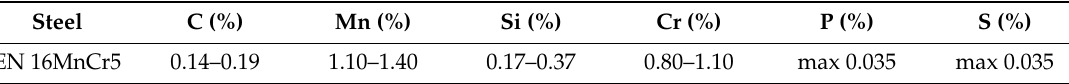
Table 3. Chemical composition of 1.7131 steel (EN